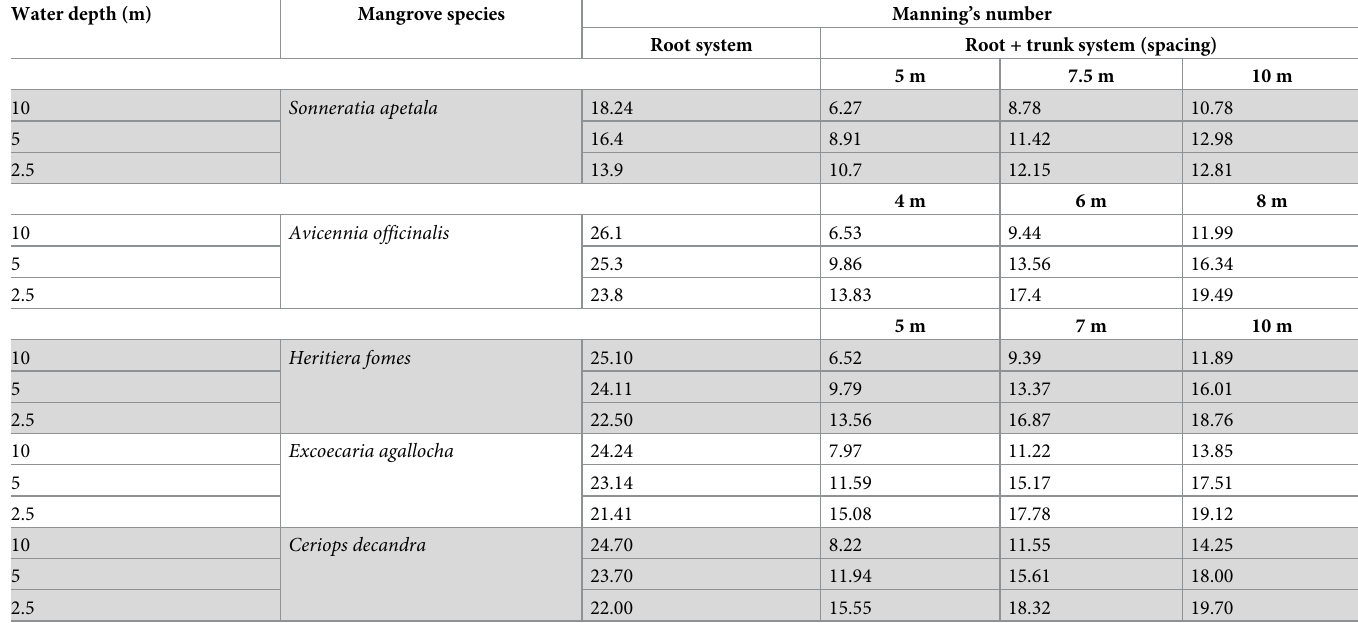
Table 2. Manning’s roughness coefficient (Measure of bed resistance) computed for root and trunk systems of selected mangrove species. Water depth (m)